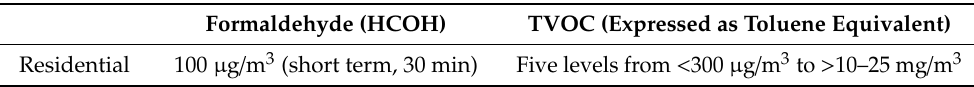
Table 1. Selected guideline values for formaldehyde (HCOH) [5–7] and total volatile organic compounds (TVOC) according to the literature [7–9]; for formaldehyde, 1.23 µ g / m 3 = 1 ppb. Formaldehyde